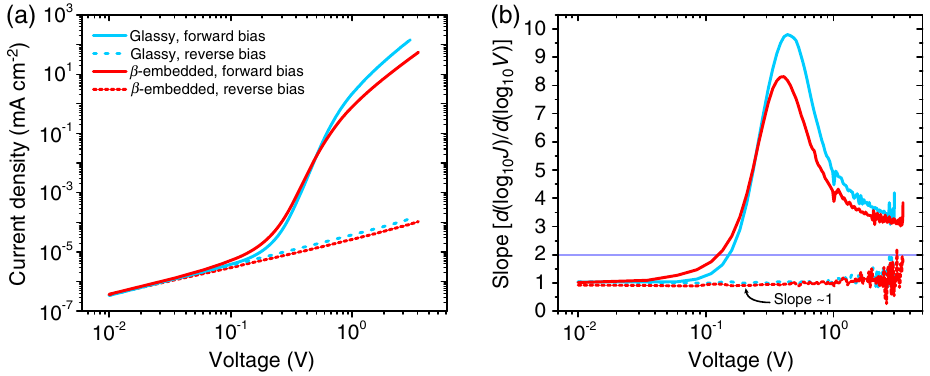
FIG. 3. (a) Double-logarithmic steady-state current density – voltage ( J − V ) plots for devices of structure ITO/PEDOT:PSS/PFO ð ∼ 135 nm Þ = MoO = Au made with glassy (blue curves) and β -phase embedded (red curves) layers. The measurements were taken x at 295 K in the dark. Forward-bias response is illustrated by solid lines and refers to hole injection through the Au = MoO contact. Reverse-bias response (dashed lines) refers to hole injection through the ITO/PEDOT:PSS blocking contact. (b) Plots of the corresponding slopes of all dual-logarithmic-scale traces shown in subplot (a) against the logarithm of voltage [slope ¼ d ð log 10 J Þ =d ð log 10 V Þ ]. The purple line at a slope of 2 marks the behavior of trap- and barrier-free space-charge-limited conduction at high bias, which is predicted by the Mott-Gurney